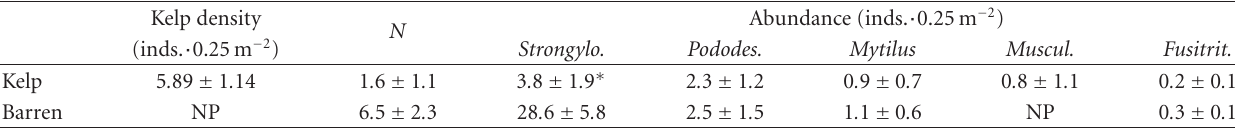
Figure 1: Map of the central and western Aleutian Islands, Alaska (inset), indicating the eight islands sampled in this study. Table 1: Kelp density and sea otter prey abundance (individuals per 0.25 m 2 ) in kelp forest and urchin barren communities in the central and western Aleutian Islands, Alaska. N is the mean of prey species counted within 0.25 m 2 quadrats in each community ( n = 8 islands with 20 quadrats per community per island). Prey species include Strongylocentrotus polyacanthus (Strongylo.) , Pododesmus machrochisma (Pododes.) , Mytilus trossulus (Mytilus) , Musculus discors (Muscul.), and Fusitriton oregonensis (Fusitrit.) . Significant di ff erences from Tukey post hoc comparisons P ≤ 0 . 05 level are indicated by ( ∗ ). NP: Not